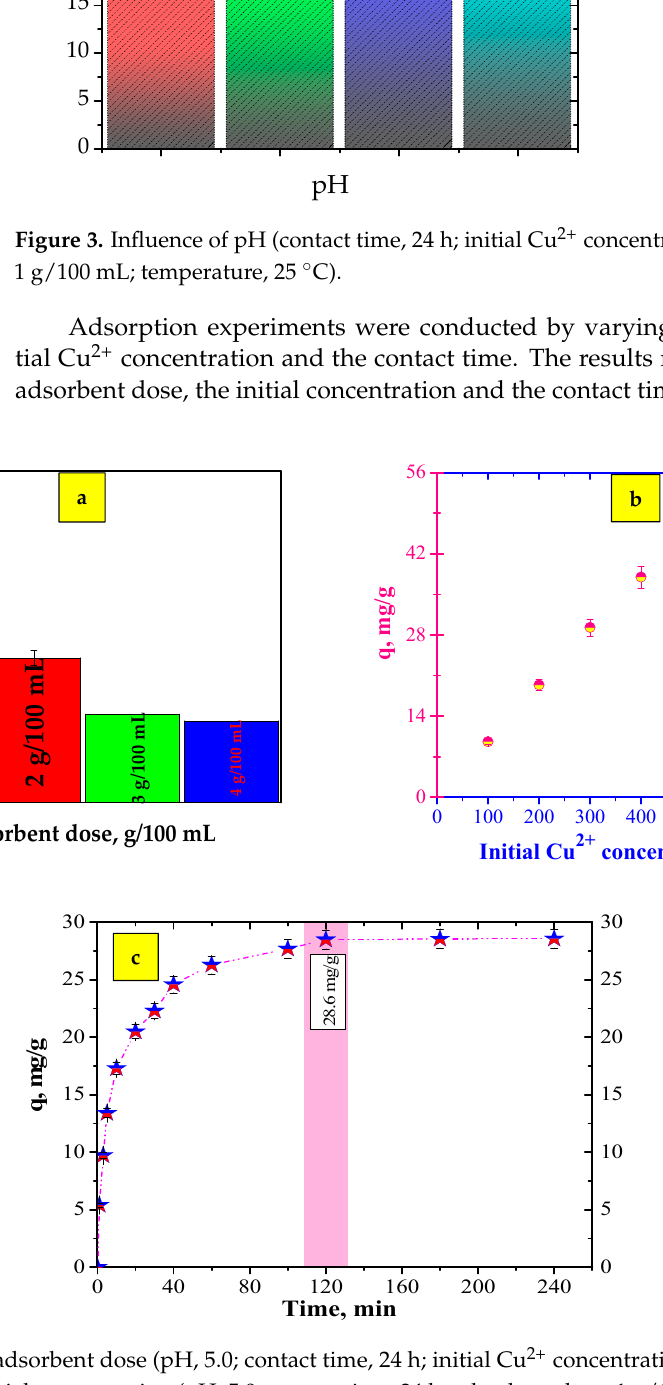
( c ) Influence of contact time (pH 5.0; adsorbent dose, 1 g/100 mL; contact time, 240 min; initial Cu 2+ concentration, 300 mg/L; Figure 4. ( a ) Influence of adsorbent dose (pH, 5.0; contact time, 24 h; initial Cu 2+ concentration, 300 mg/L; temperature, 25